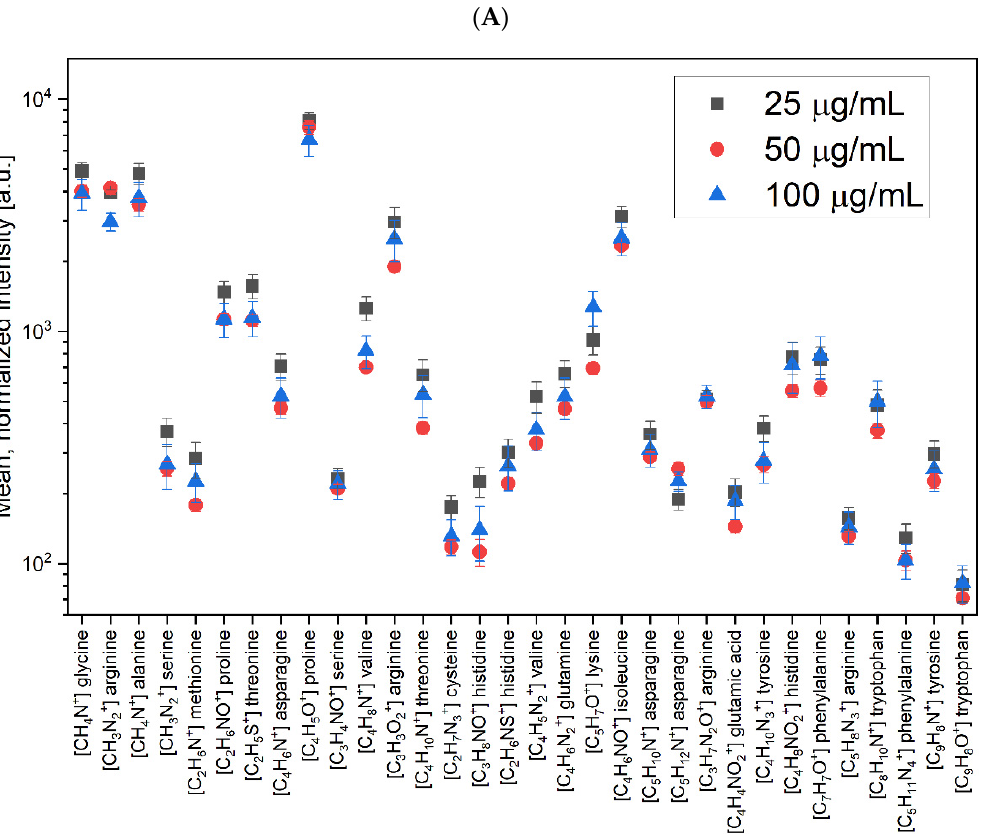
Figure 5. Values of the mean normalized intensities for the characteristic amino acid peaks in ( A ) positive and ( B ) negative ions for the three concentrations of LACT deposited on the surface of functionalized silicon with APTES and GA.